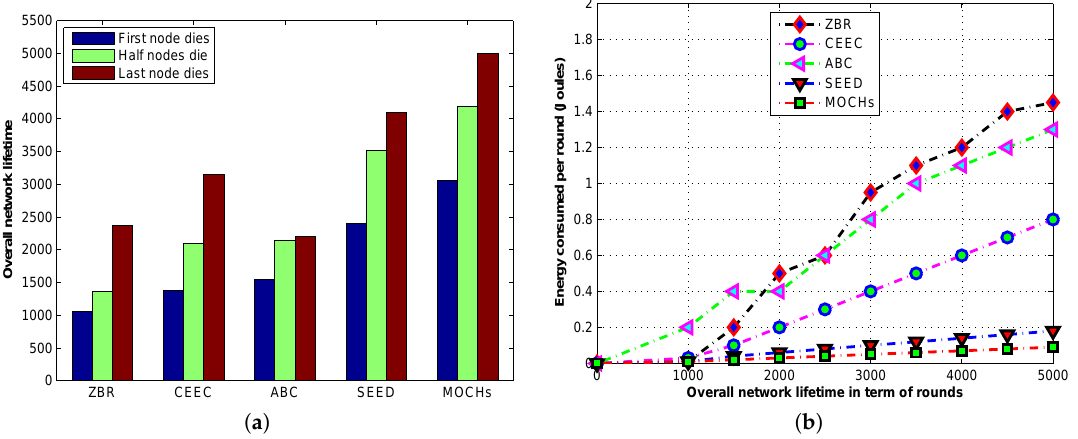
Figure 12. The stable and unstable regions comparison of MOCHs with SEED, CEEC, ABC, and ZBR in the lifetime of the network. ( a ) The network stability comparison; ( b ) The analysis of energy consumption per round. Table 4. Round history of dead nodes over simulations of five WSNs (with 200